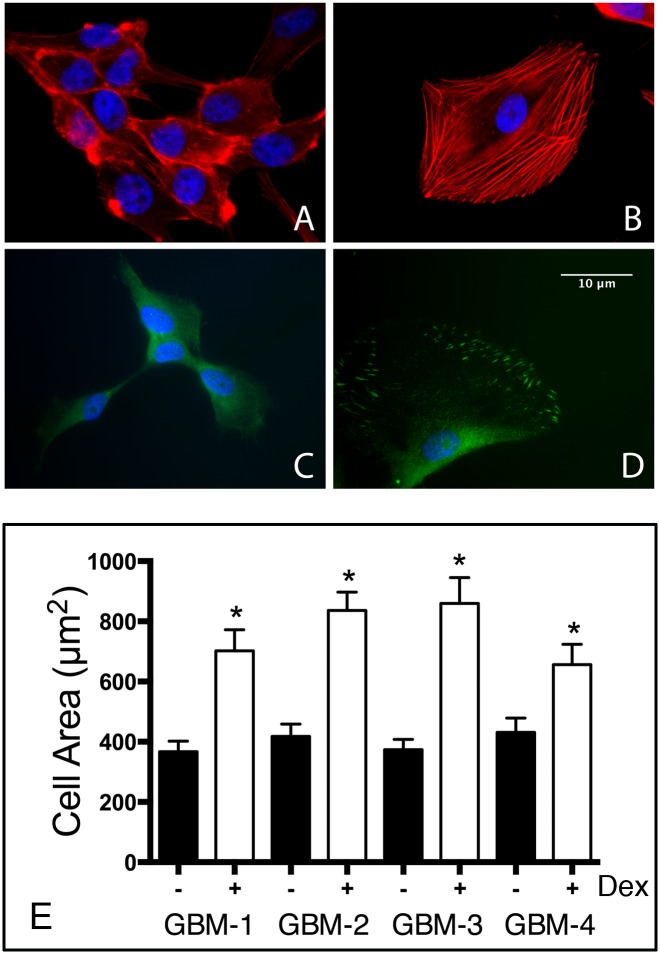
Dex treatment results in a change in cell shape, actin organization and pFAK localization.GBM-3 cells were either left untreated (A, C) or were treated with 10−7 M Dex for 24 hours (B, D), whereupon they were fixed and permeabilized and labeled with either rhodamine-phalloidin or with a pFAK antibody, and DAPI as counterstain. Note that Dex treatment resulted in a change in cell shape and a significant reorganization of actin from cortical (A) into stress fibers (B). This was accompanied by a change in the localization of pFAK from cytoplasmic (C) to sites of cell-ECM adhesion (D). ImageJ was used to measure cell area in the absence or presence of Dex for the 4-GBM lines. Pair-wise comparison by Student t-test showed a significant increase in cell size in response to Dex treatment (p<0.05).